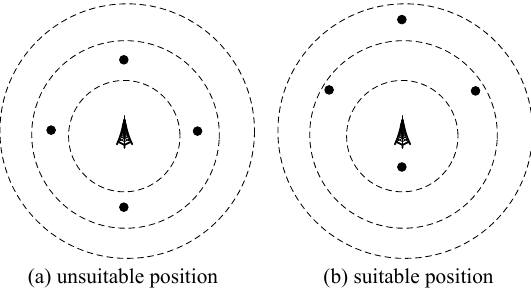
Figure 1. Suitable and unsuitable positions for the base